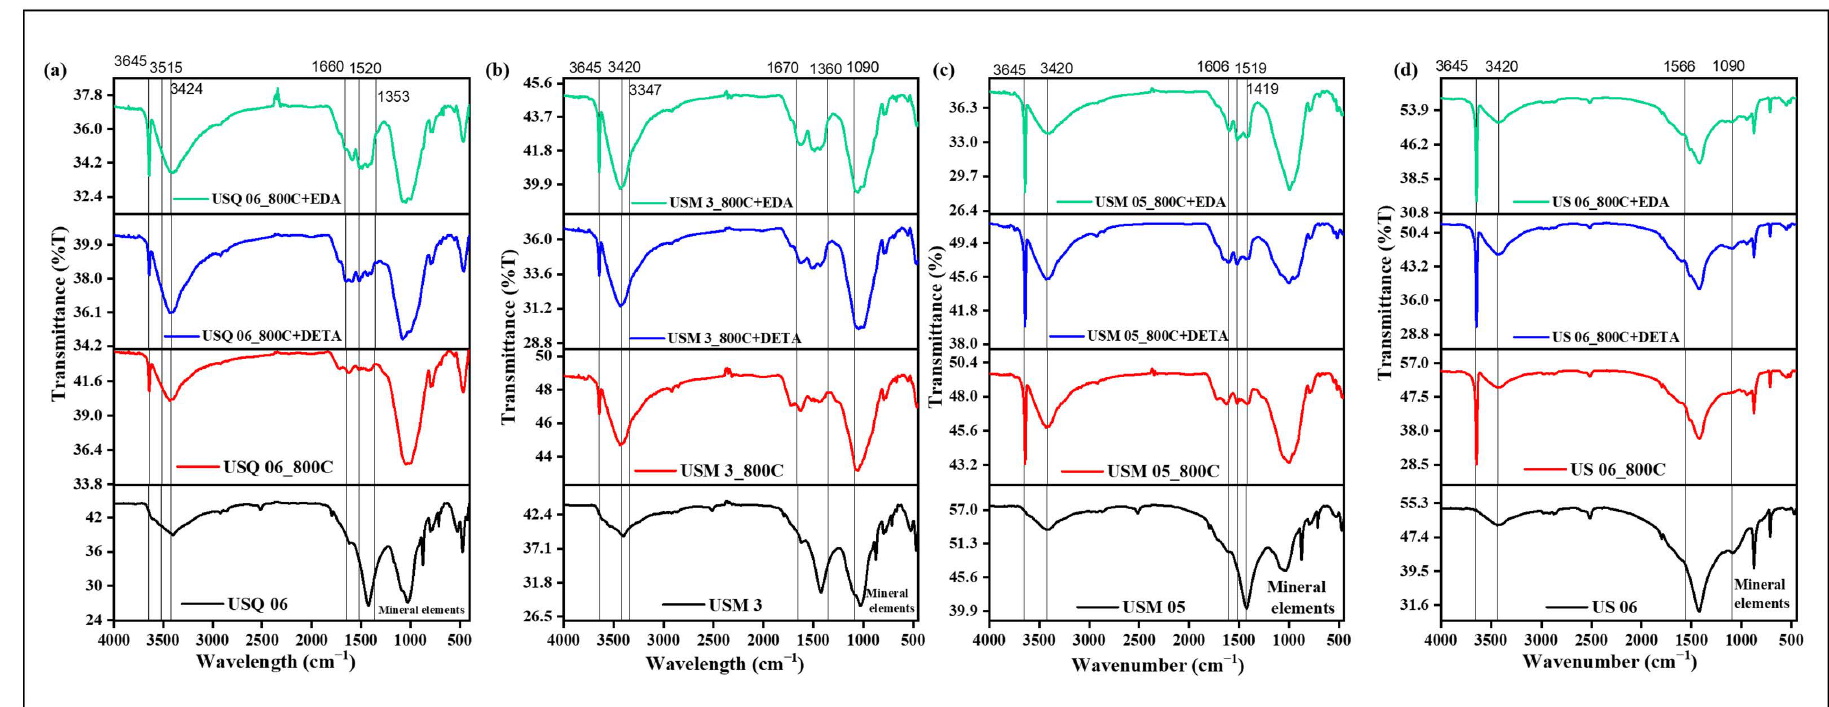
Figure 5. Appearance of new functional groups after the pyrolysis and amine treatments of samples ( a ) USQ 06, ( b ) USM 03, ( c ) USM 5, and ( d ) US